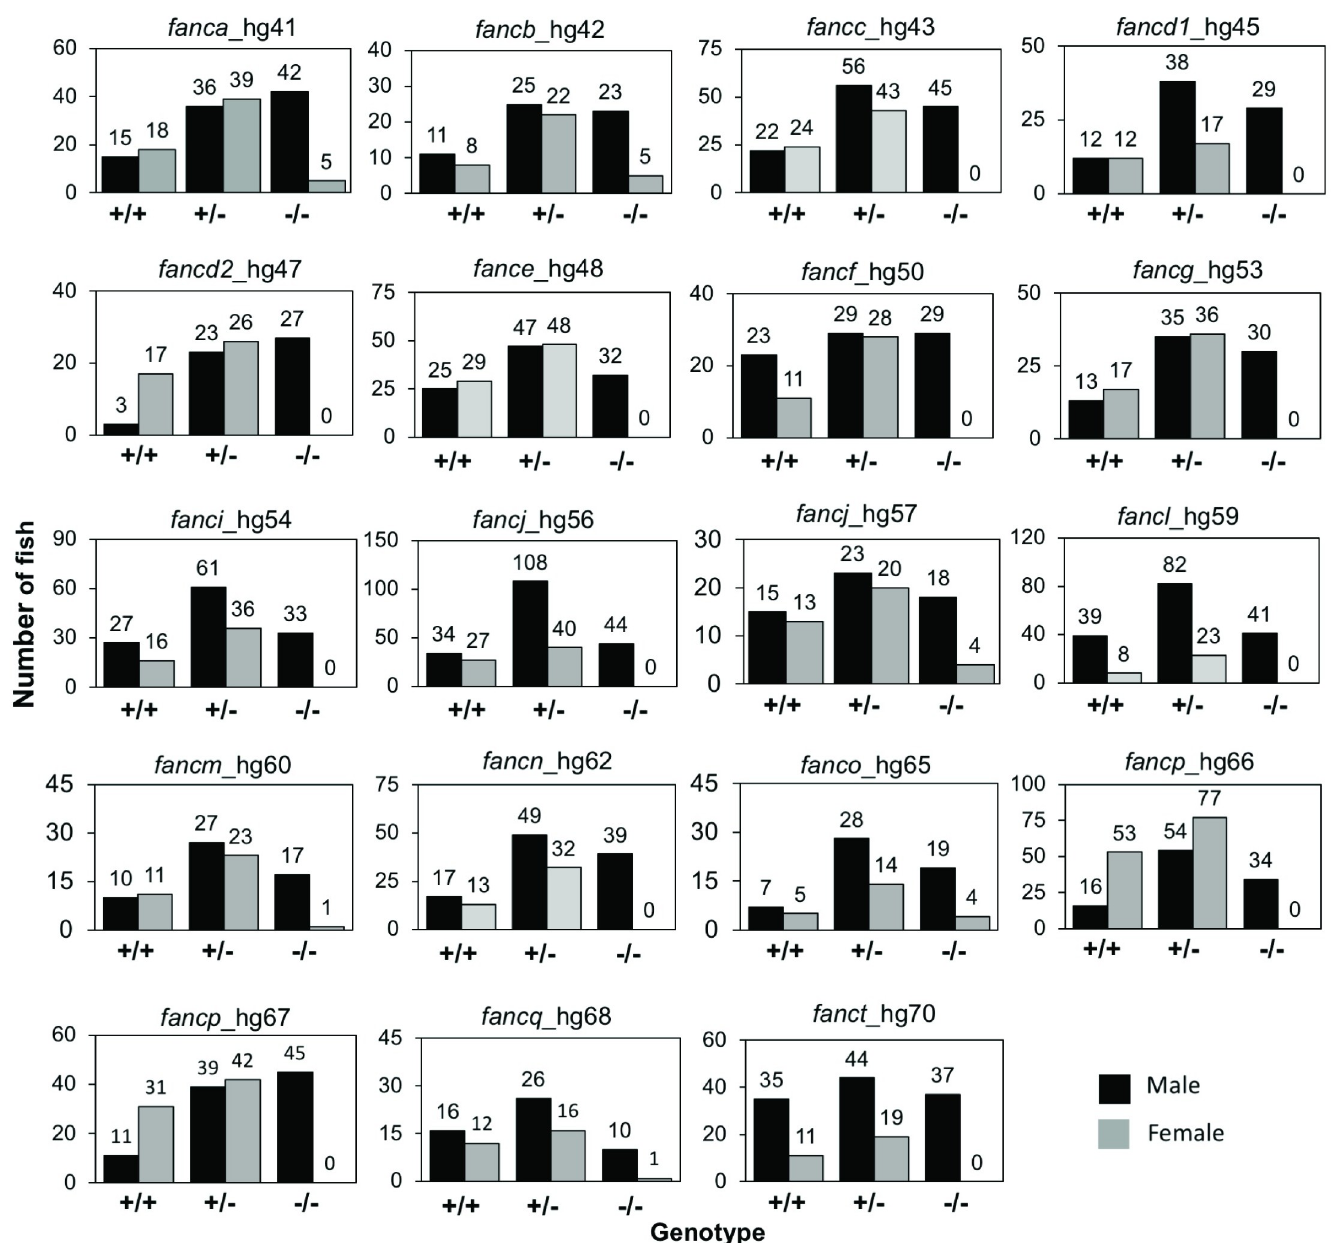
Fig 5. Female-to-male sex reversal was observed in FA gene knockouts. Progenies from inbred heterozygous fish for each gene were genotyped around 3 months of age and the sex was determined. For each gene, the data is shown as bar graph for number of male and female fish in each genotype category as marked on the X-axis. Numbers at the top of bar depict the number of fish. Significantly increased number of males were observed for fanca , fancb , fancm , fanco , and fancq homozygous knockouts, while only males were observed for the rest. For fancj -/- , no females were observed in fancj hg56/56 , whereas greatly reduced number of females were observed in fancj hg57/hg57